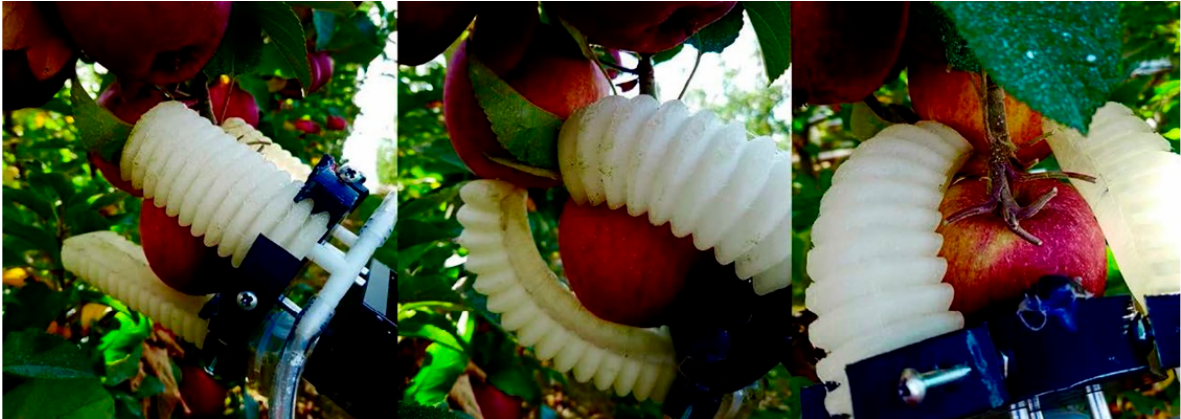
Figure 6. Indicative apple harvesting end effectors proposed by Hohimer et al. (Reprinted/adapted with permission from Ref. [63]. 2019, Hohimer, C.J.).